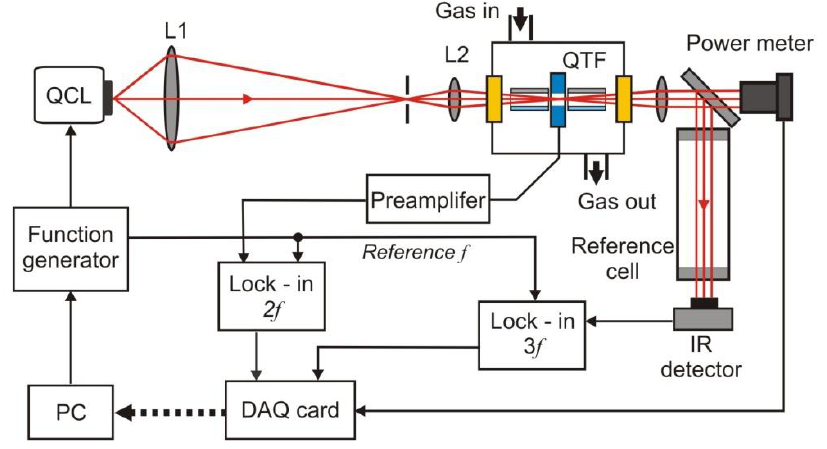
Figure 15. Setup of quartz-enhanced photoacoustic spectroscopy